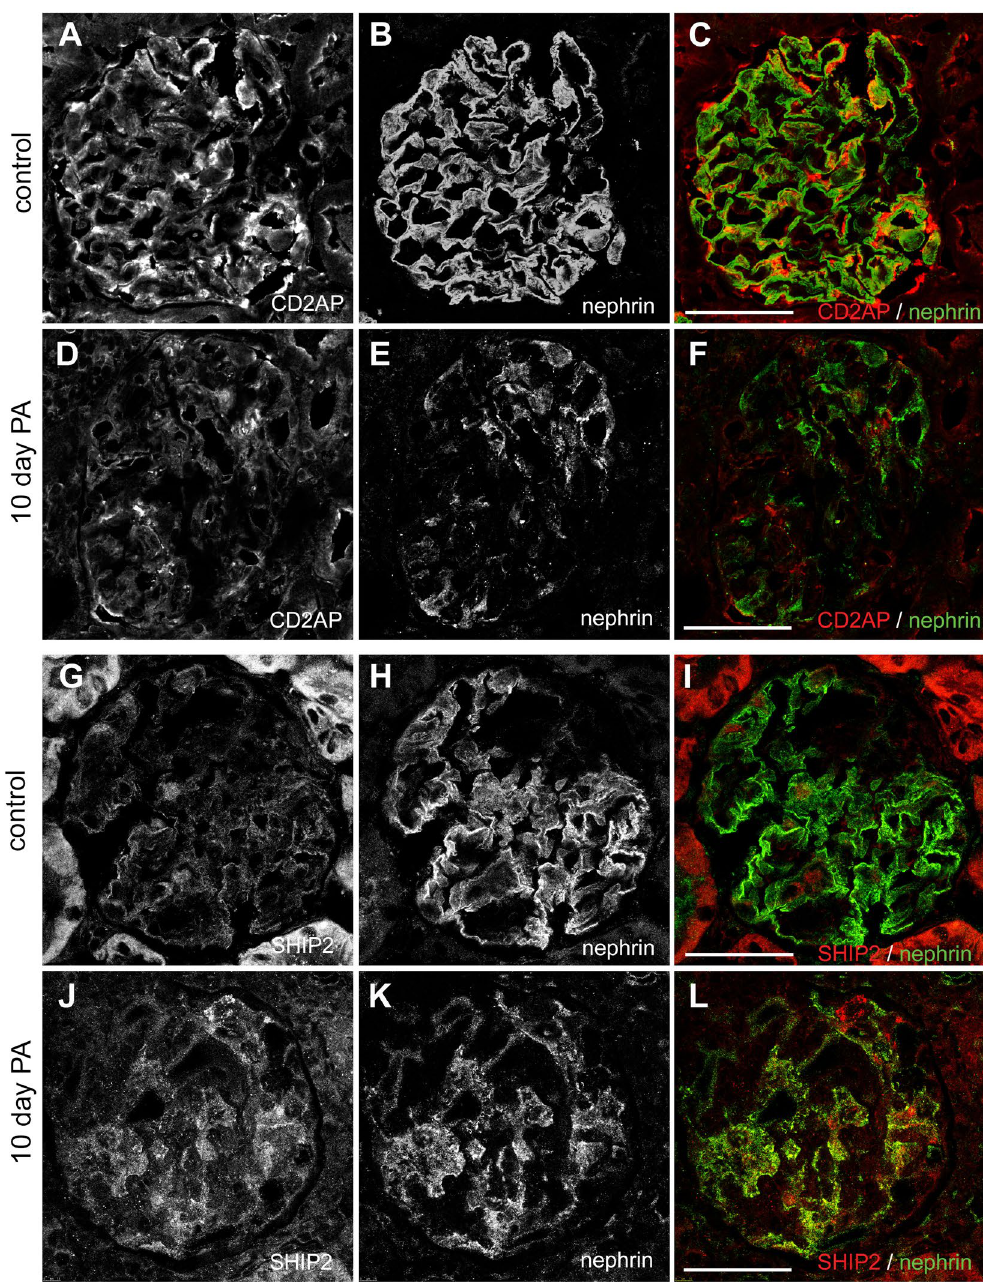
Figure 8. CD2AP expression appears to be reduced and SHIP2 expression increased in kidneys of PA-induced nephrotic rats. ( A – C ) In normal rat glomerulus CD2AP is expressed in podocytes and partially co-localizes with nephrin. ( D – F ) In PA-induced nephrotic rats 10 days after PA administration, both CD2AP and nephrin appear weak and show patch-like accumulation of the signal. ( G – I ) In normal rat glomerulus weak signal for SHIP2 is observed in podocytes as visualized by double labelling for nephrin. ( J – L ) In PA-induced nephrotic rats 10 days after PA administration, SHIP2 staining appears in diffuse, patch-like accumulations similarly as nephrin. Scale bar: 20 µ